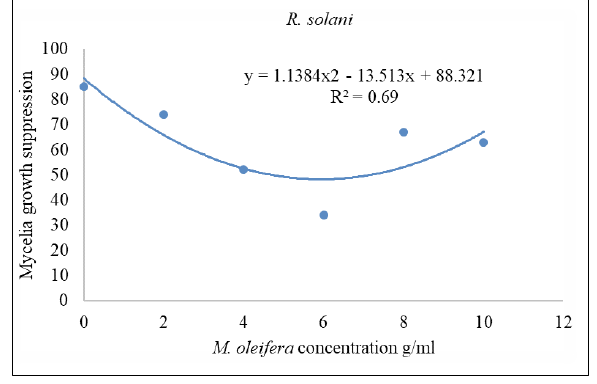
Quadratic relationship between percentage mycelia growth of Rhizoctonia solani and Moringa oleifera plant extract